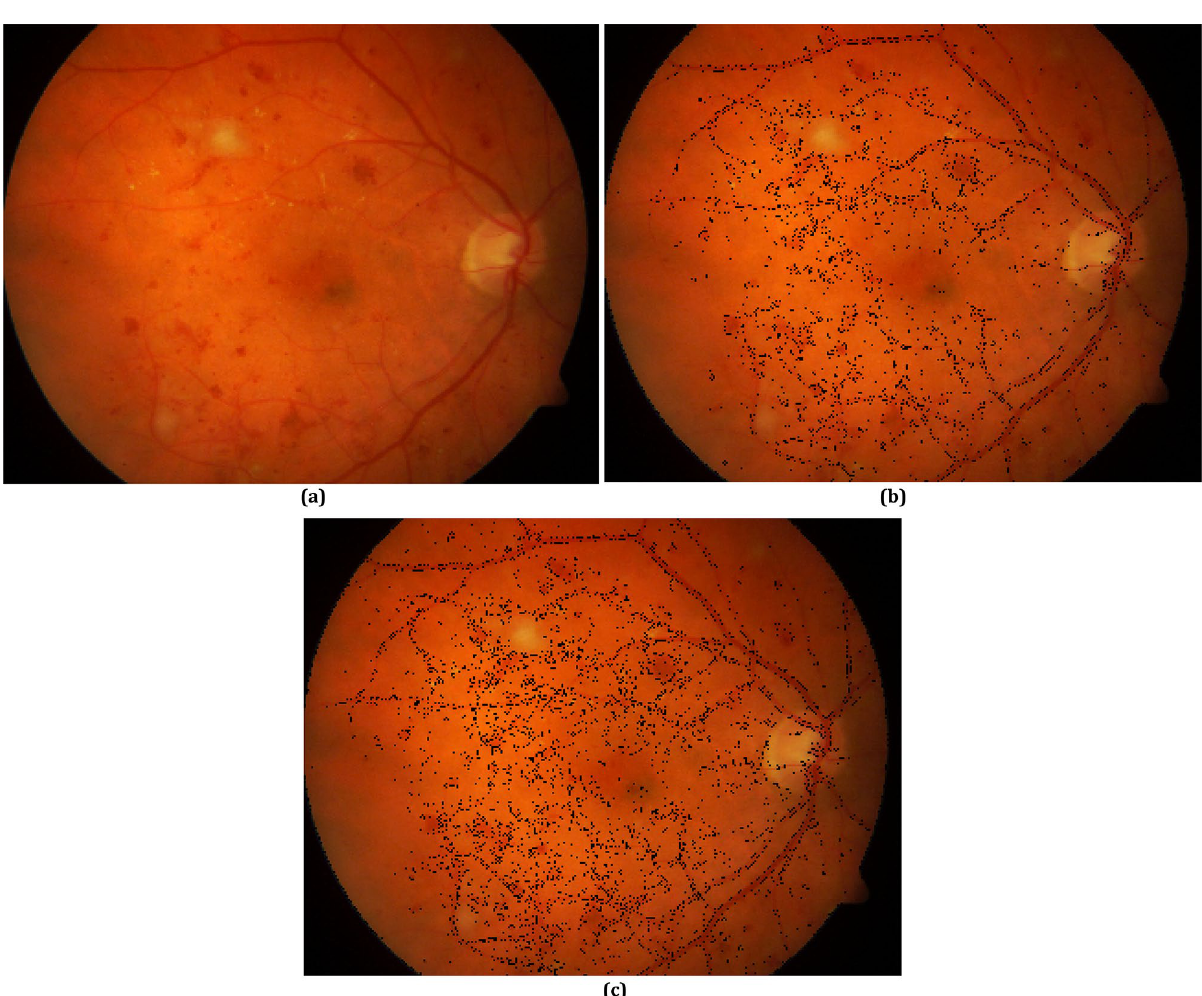
Figure 3. ( a ) a fundus image, boundary pixels for ( b ) th Diff = 0.12, ( c ) th Diff =